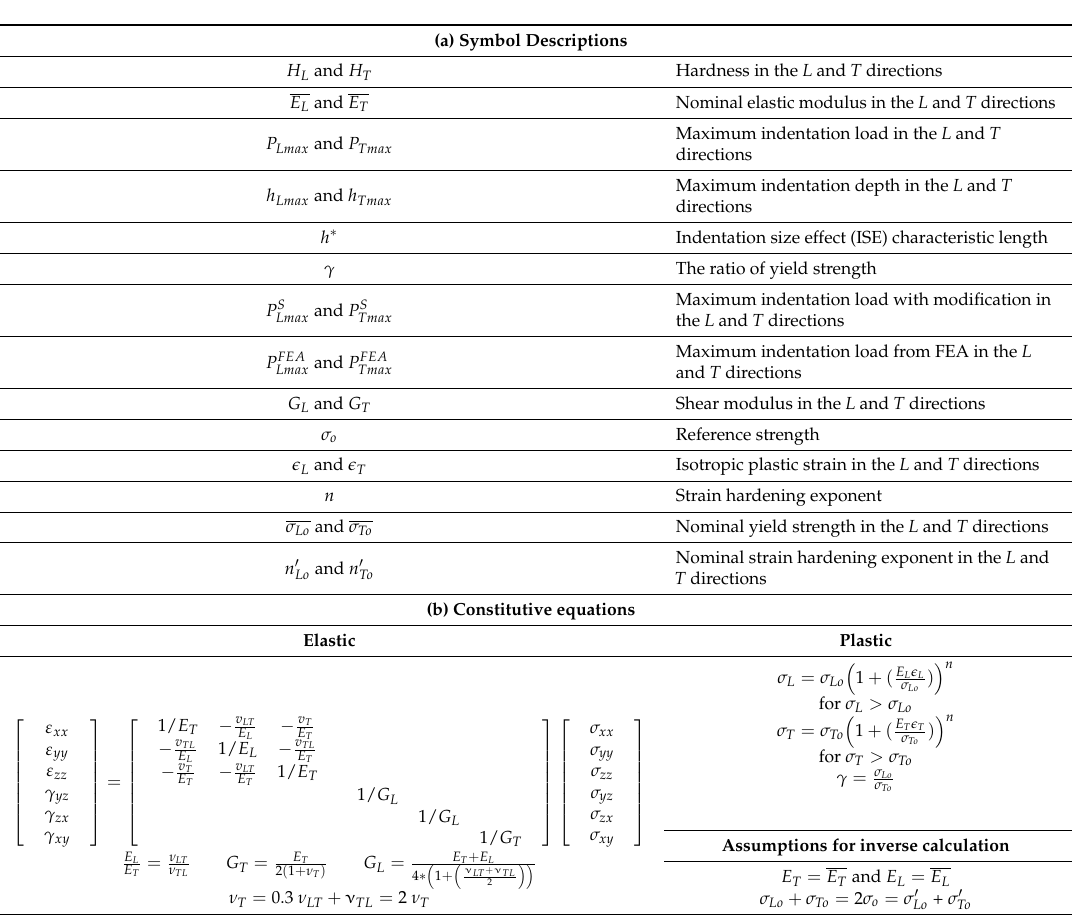
Table 2. Definitions of the terms and the summary of the constitutive equations used for the inverse